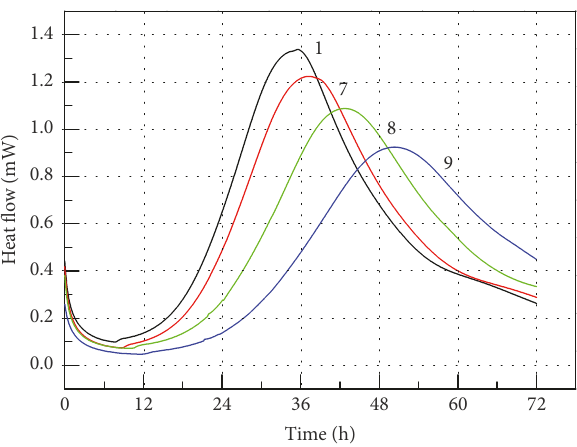
Figure 16: Heat flow versus time of references with SRA.